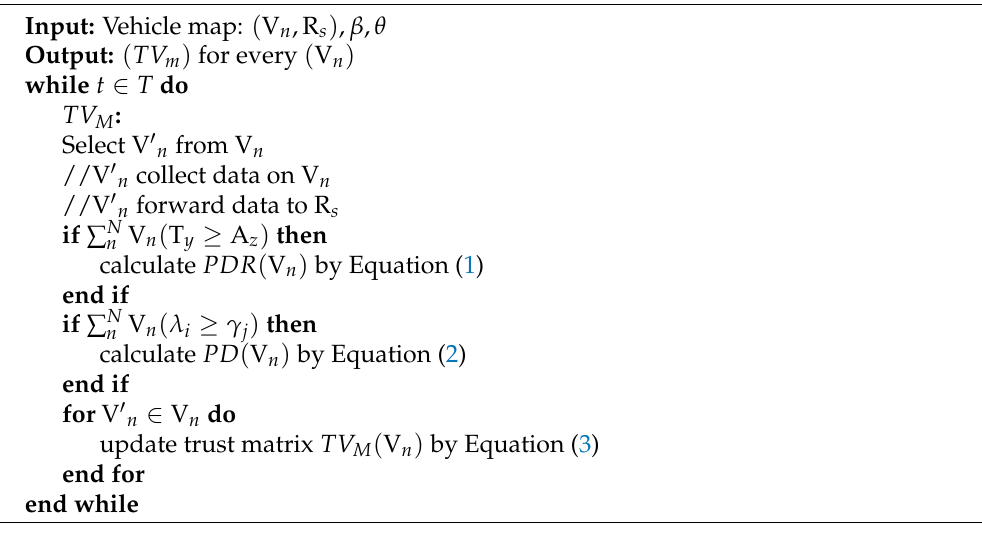
Algorithm 2 Calculating Trust Value ( TV ( V n ) )